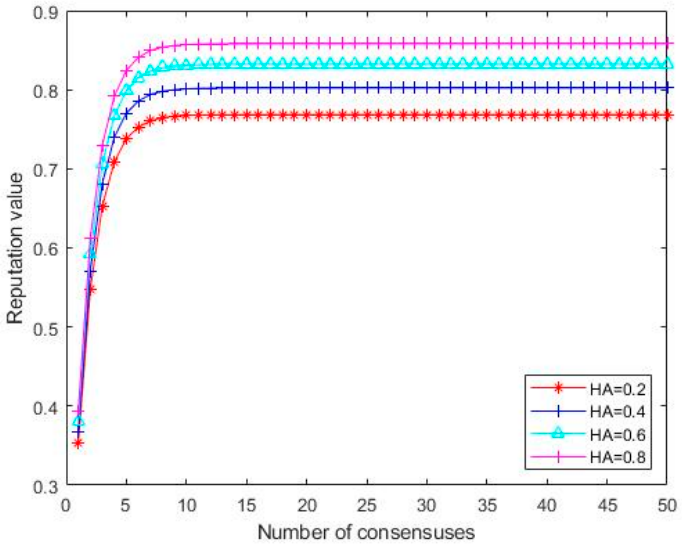
Figure 7. E ff ects of node online time on reputation. Figure 7. Effects of node online time on reputation.